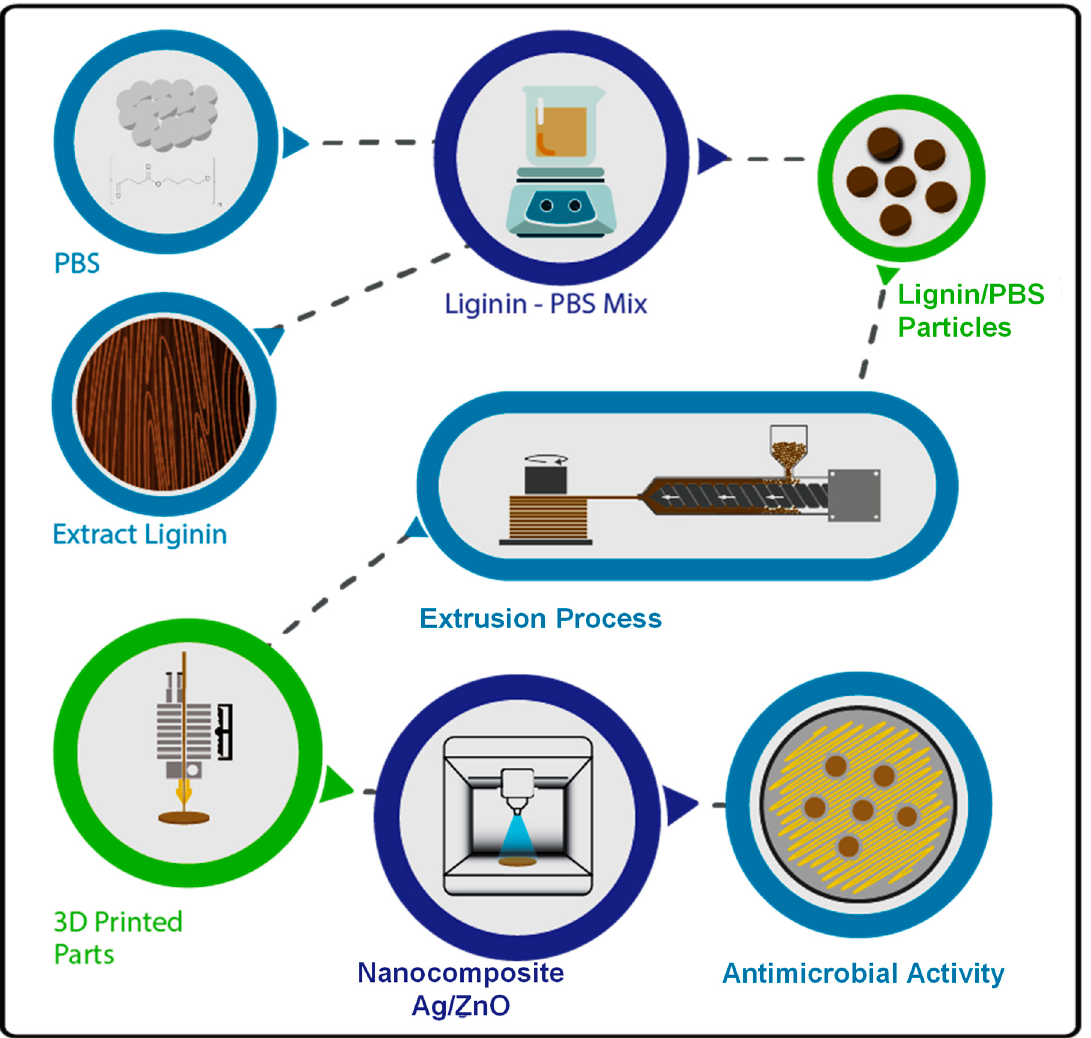
Figure 1. The schematic presentation of the creation of nanocoated PBS/lignin composite grafts by FDM printing and RF sputtering.